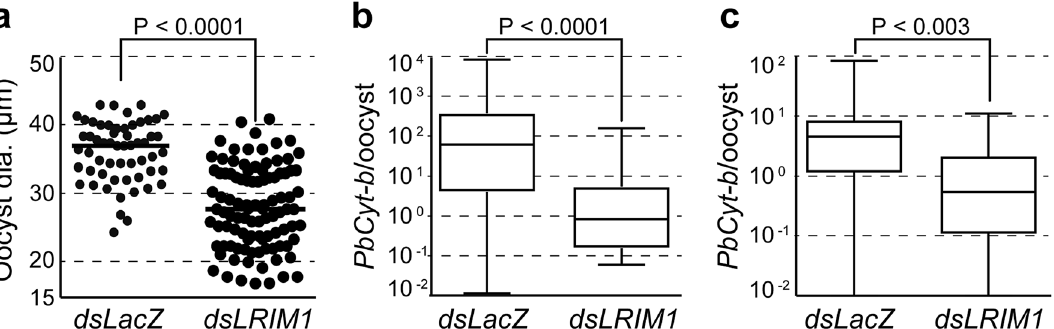
Figure 2. Effect of crowding on P. berghei oocyst growth. ( a ) Oocyst diameter (dia.) in LRIM1 and LacZ dsRNA injected mosquitoes. Data were generated from two independent biological replicates. ( b , c ) PbCyt-b DNA abundance in LRIM1 and LacZ dsRNA injected mosquitoes 7 ( b ) and 14 ( c ) dpi. Data were generated from three independent replicates. Horizontal lines in dot plots and boxplots indicate